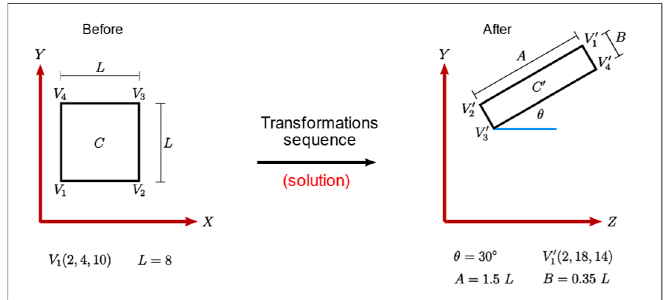
Figure 3. An example of a “before and after” learning exercise.